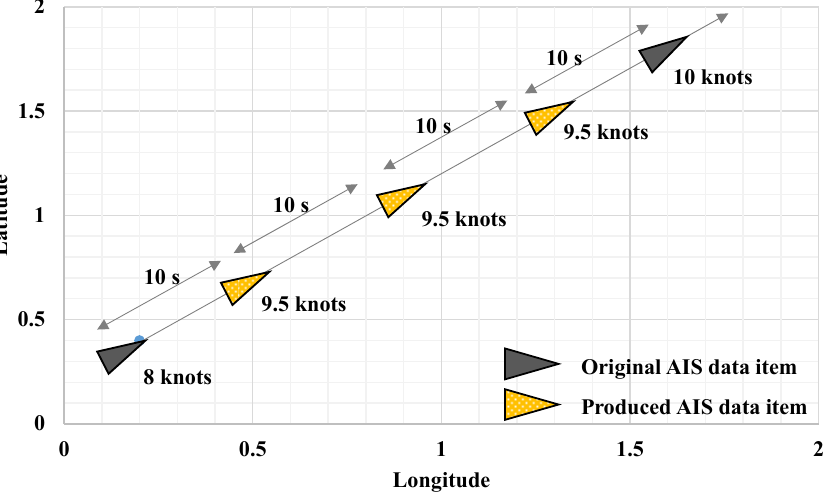
Figure 3. Example of the process of producing additional AIS data items.